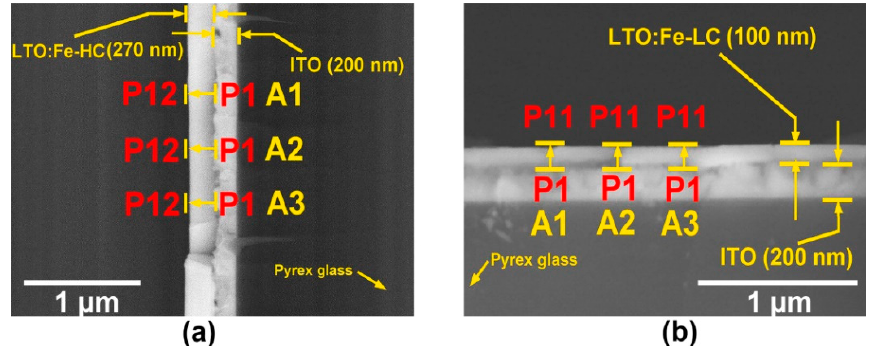
Figure 4. Thin-film thickness: ( a ) LTO:Fe-HC; ( b ) LTO:Fe-LC.